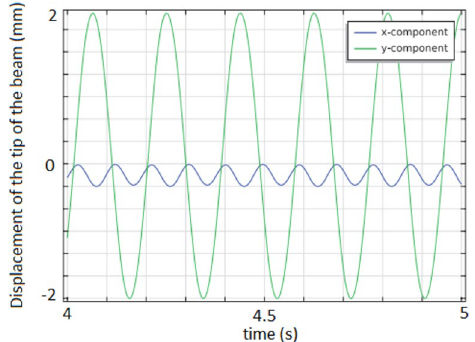
Fig. 13 Tip displacement of the elastic beam in the x and y direc- tions